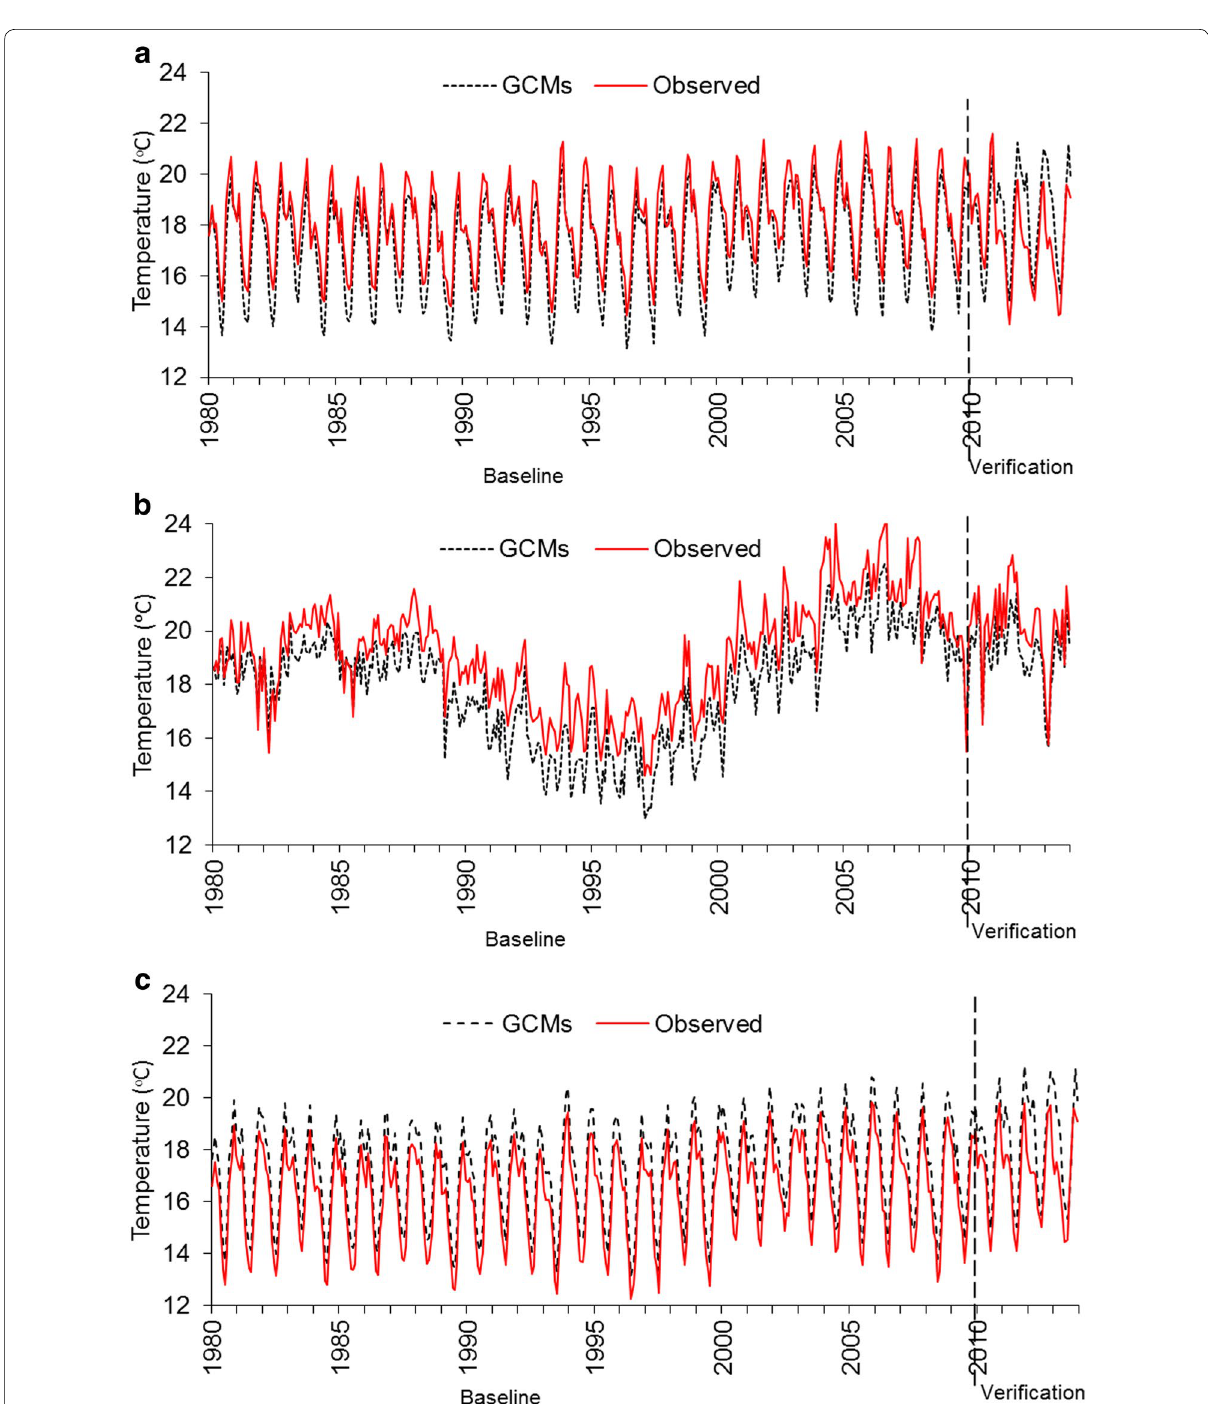
Fig. 13 Observed and GCMs-derived mean monthly temperature for the three weather stations ( a Kihanga, b Ikweha and c Kinyanambo) during baseline and verification